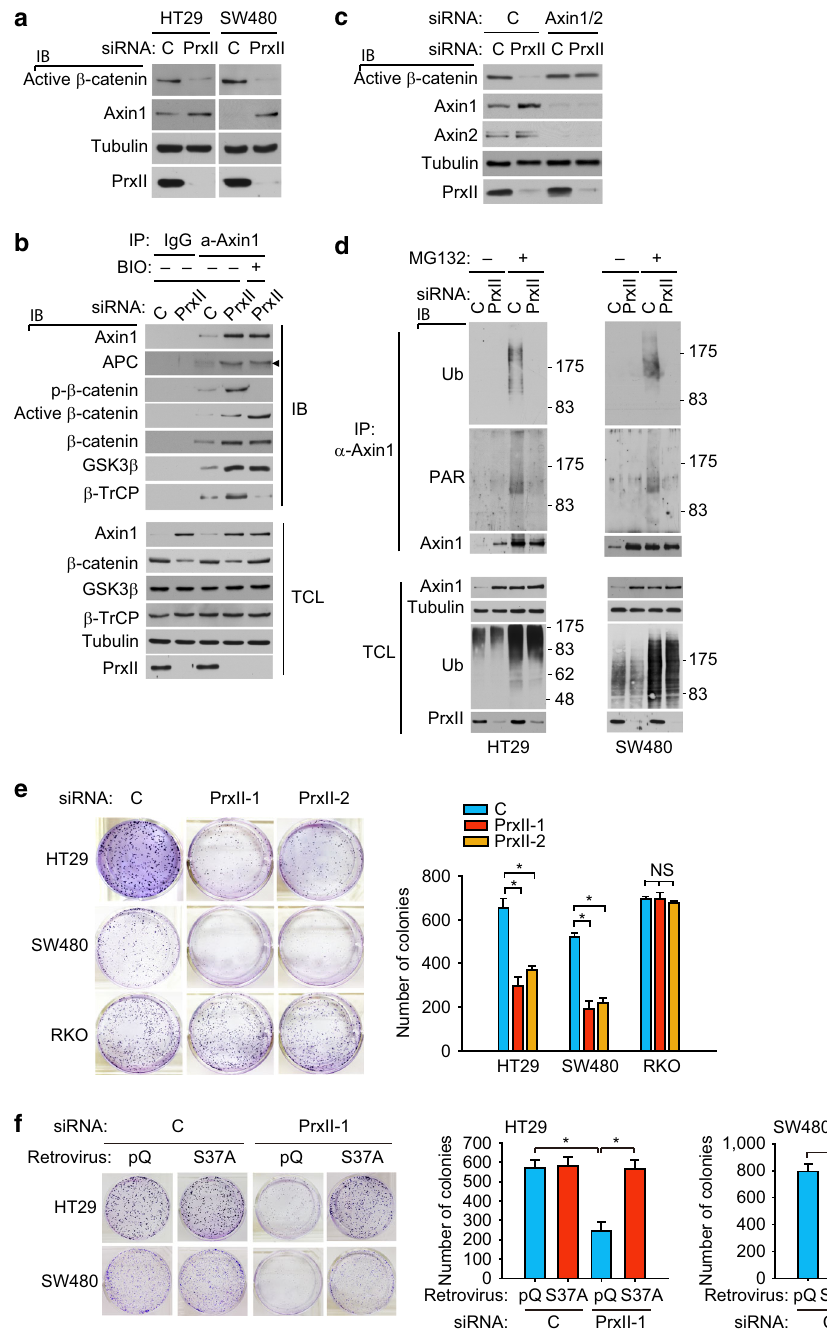
Fig. 3 PrxII promotes poly(ADP) ribosylation-dependent Axin1 degradation and tumorigenic activity in APC-mutant CRC cells. a ΗΤ 29 and SW480 cells were transfected with control or PrxII-1 siRNA and immunoblotted (IB) for active β -catenin and Axin1. b SW480 cells were transfected with control or PrxII-1 siRNA and lysed for immunoprecipitation (IP) with control IgG or anti-Axin1 antibody. BIO was treated to SW480 cells for 1 h before lysis. The IP complexes were immunoblotted for components of β -catenin destruction complexes. Arrowhead indicates a truncated APC protein. c SW480 cells were co-transfected with indicated siRNAs including PrxII-1 and Axin1/2-speci fi c siRNAs and immunoblotted for active β -catenin. d HT29 and SW480 cells were transfected with control or PrxII-1 siRNA and lysed for IP with anti-Axin1 antibody. MG132 was treated to SW480 cells for 1 h before lysis in order to accumulate ubiquitinylated proteins. The IP complexes were immunoblotted for PARsylation (PAR) and ubiquitination (Ub). The molecular weight markers are labeled in kilodaltons. e RKO, HT29, and SW480 cells were transfected with each of two PrxII siRNAs and then cultured for 10 days. The colonies were stained with crystal violet and counted. Data in the graph are the average number of colonies ± s.d. ( n = 3, * P < 0.001). NS, statistically not signi fi cant. f HT29 and SW480 cells expressing β -catenin S37A mutant were transfected with PrxII-1 siRNA and then cultured for 10 days. The colonies were stained with crystal violet and counted. Data in the graph are the average number of colonies ± s.d. ( n = 3, * P < 0.001, ** P < 0.005). All experiments were independently repeated three times. Total cell lysates (TCL) were immunoblotted as control for the amount of indicated proteins in the lysate. Fire fl y luciferase-speci fi c siRNA was used as control